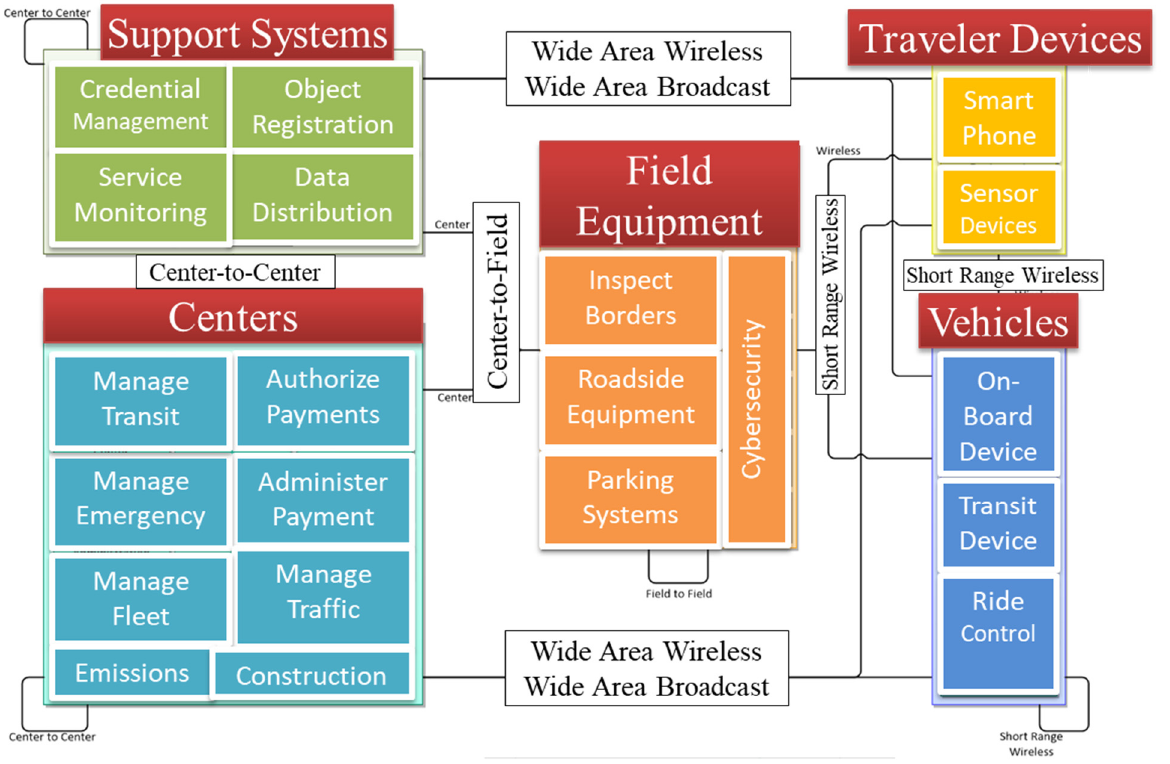
Figure 1. The connected transportation